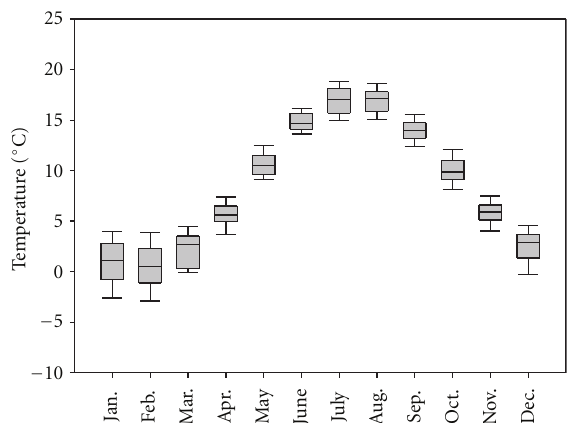
Figure 1: Monthly average temperature in Scania, Sweden, from 1961 to 2010. Note: the boundary of the box closest to zero indicates the 25th percentile, a line within the box marks the median, and the boundary of the box farthest from zero indicates the 75th percentile. Whiskers (error bars) above and below the box indicate the 90th and 10th